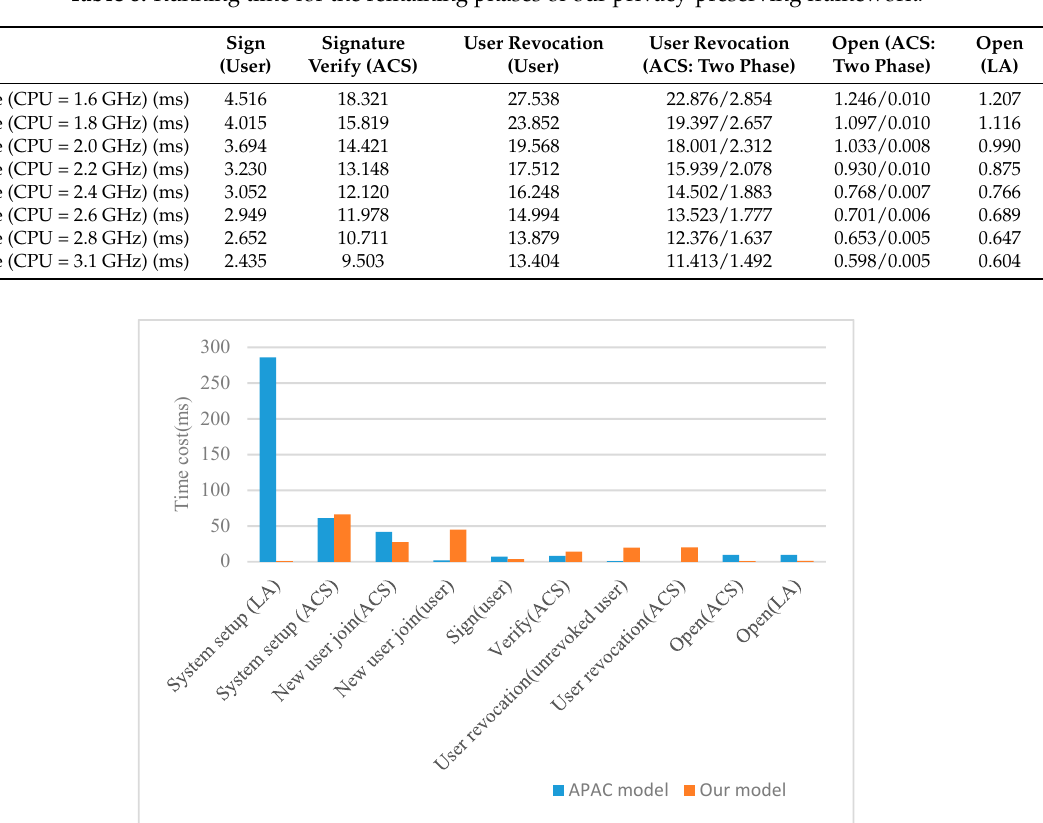
Table 8. Running time for the remaining phases of our privacy-preserving framework.